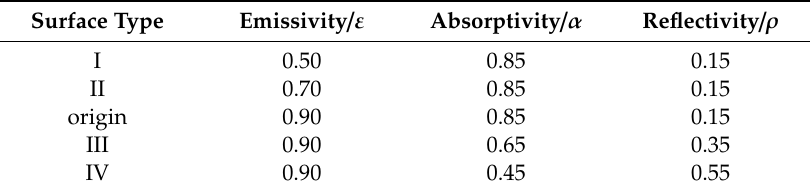
( b ) Figure 13. Influence of emissivity on regulation of heat transfer and temperature gradient: ( a ) radiant heat dissipation of dashboard; and ( b ) maximum temperature and temperature gradient.